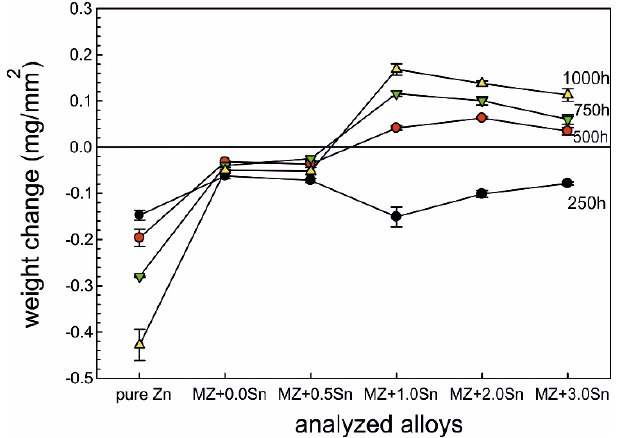
Figure 1. Weight change after corrosion measured on as-cast samples.